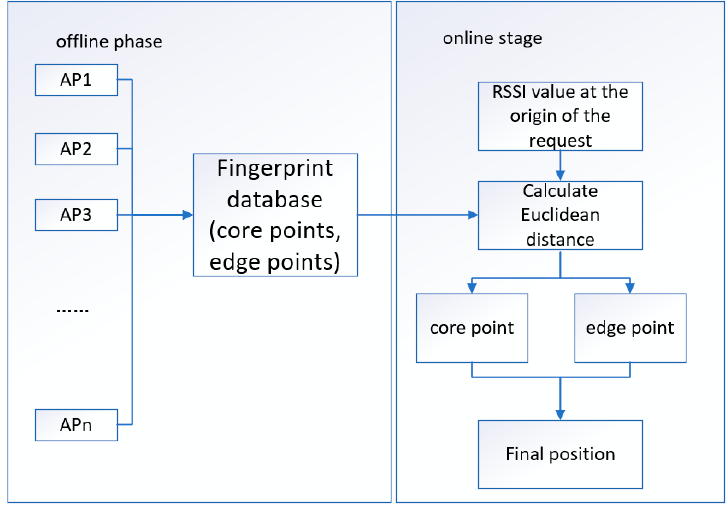
Figure 6. The overall positioning process of the system is divided into offline stage and online stage.